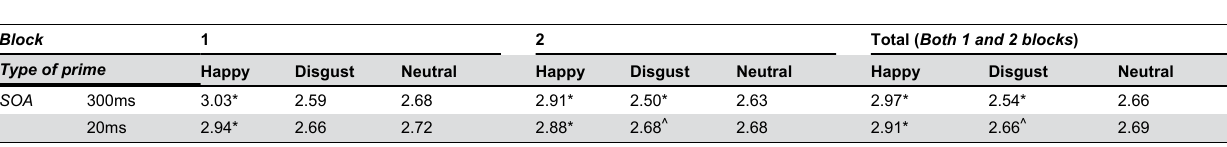
Table 1. Mean liking ratings for each SOA, type of prime and block.